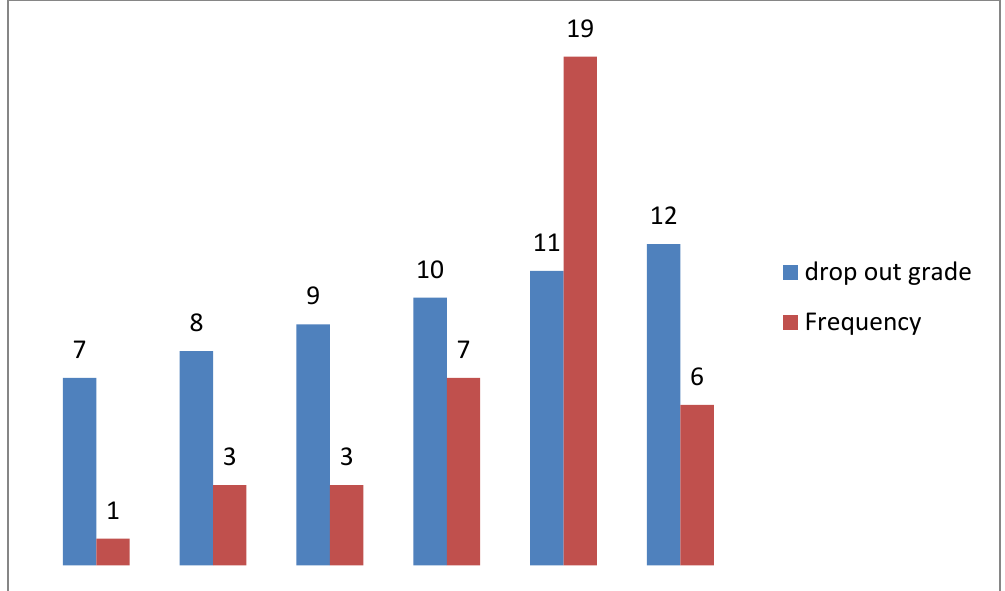
Figure 3. Drop out grade (n = 39) of participants.